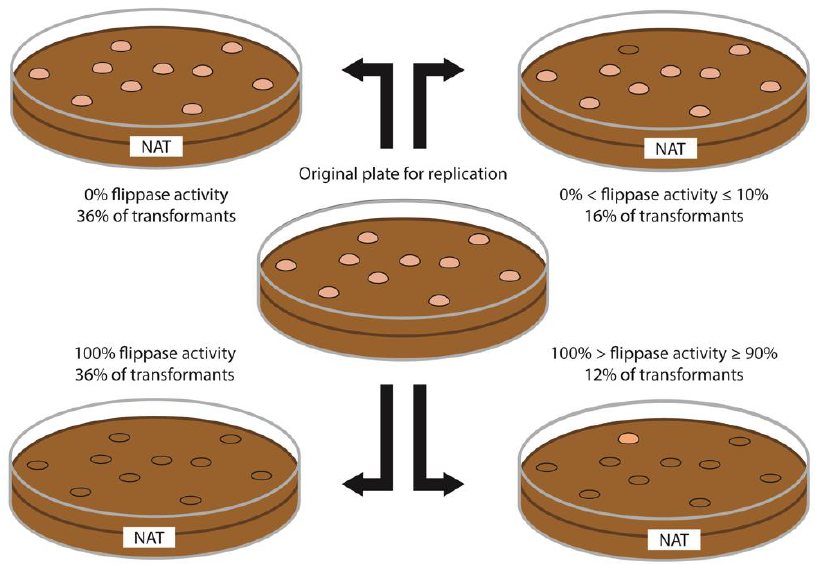
Figure 2. Representation of the plate replication results after activation of the FLP recombinase. Use of Nourseothricin on a plate is represented with the text NAT on the diagram. A total of 25 transformants of the strain NYCY3047 were examined after FLP recombinase activation showing a FLP activity either equal to or higher than 90% activity or equal to or lower than 10%. Most of the transformants (72%) showed activity in all or none of the colonies, while the rest had either very high or low FLP activity. These results confirm the efficacy of the SAP2 promoter/FLP recombinase system on M. pulcherrima even though none of the HR transformants show any FLP activity, therefore impeding a second round of transformation with the same construct.